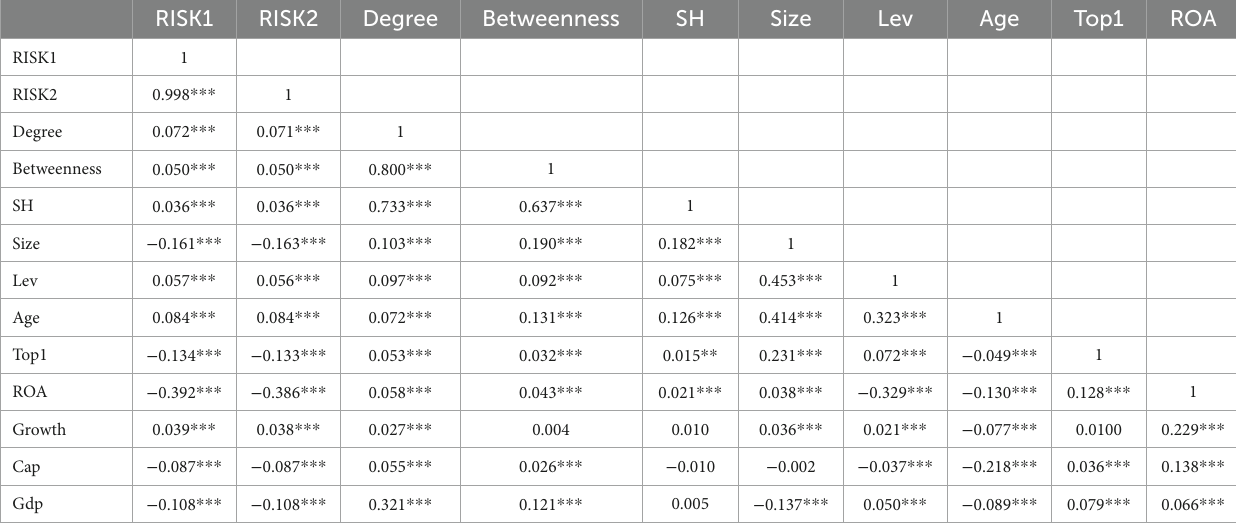
TABLE 3 Pearson correlation coefficient